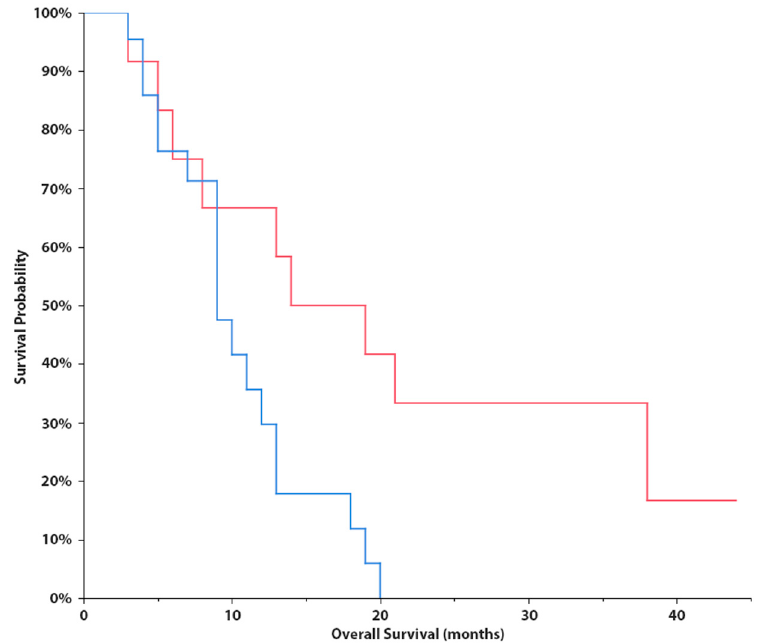
Figure 4. Kaplan-Meier survival curves estimating overall survival in patients with glioblastoma according to combined cerebrospinal fluid levels of miR-10b and miR-196b (low levels in red - median OS = 16.5 months; and high levels in blue - median OS = 9 months; p = 0.0170, Log-Rank